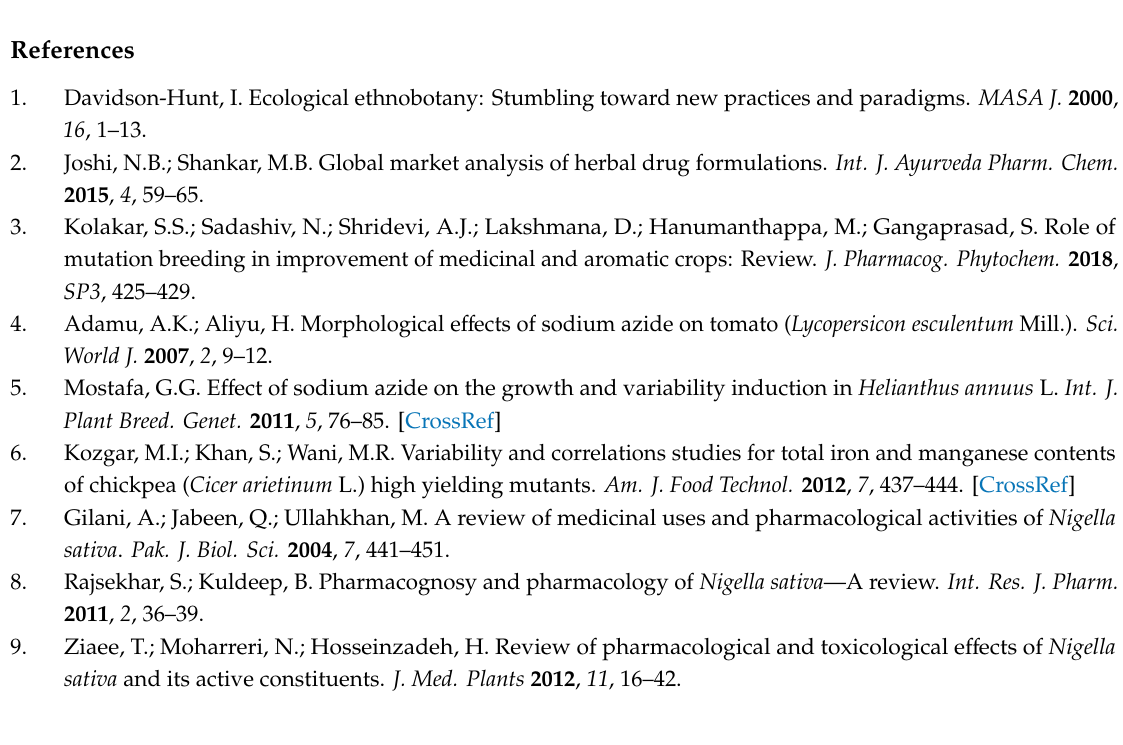
Table S1: List of phenotypic categories and mutant characteristics, Table S2: Macro-mutant lines of Nigella sativa L., Table S3: List of primers for real time PCR, Figure S1: 2-D gel patterns of leaf proteins of N. sativa using IPG strips with di ff erent pH ranges, Figure S2: MASCOT search